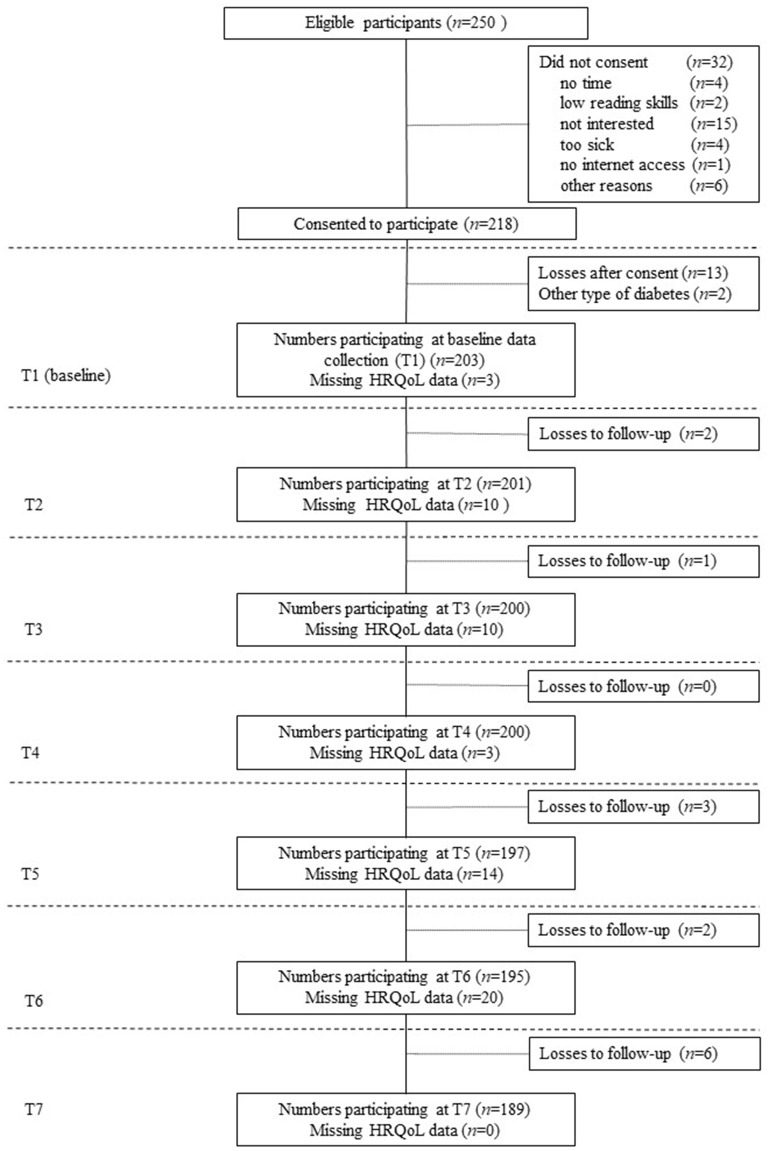
Flow diagram—study participation over time. Loss to follow-up was defined, as missing health-related quality of life (HRQL) data for all subsequent measurement points. Otherwise, missing HRQL data was considered as missing for the respective measurement point.